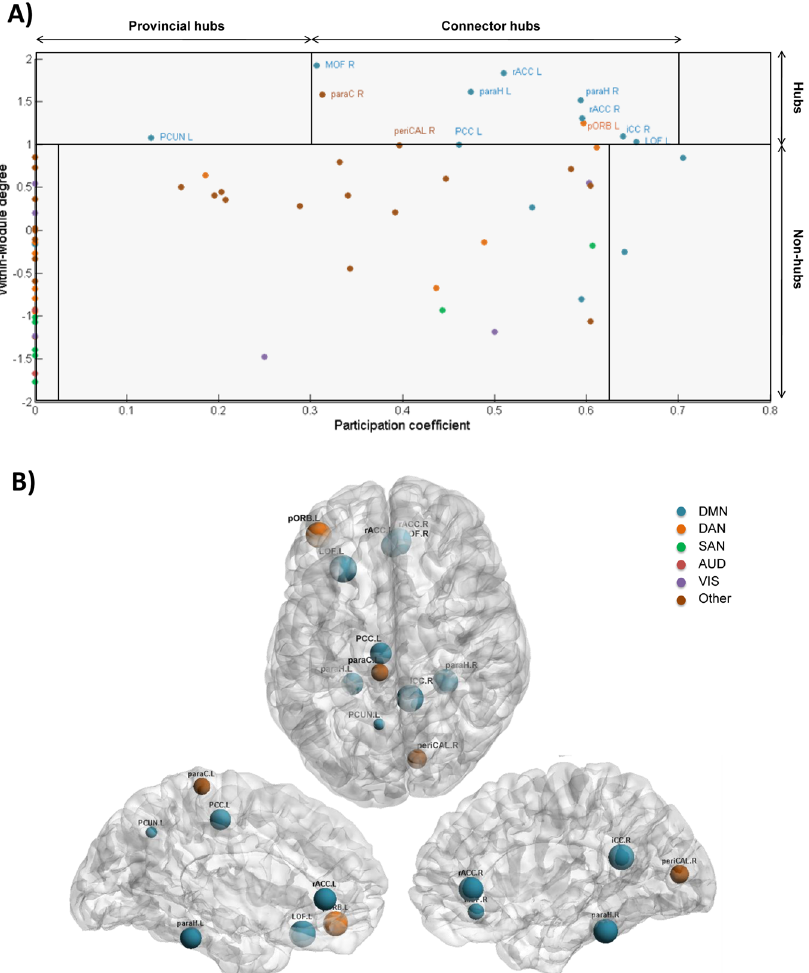
Figure 3. Static analysis: modularity. ( A ) The scatter plot of the participation coefficient and the within module degree for the 68 brain regions. Based on 57 , three main areas can be identified: Non-hubs, provincial and connector hubs. ( B ) The spatial locations of the identified hubs on the cortical surface. Names and abbreviations of the brain regions are listed in Table